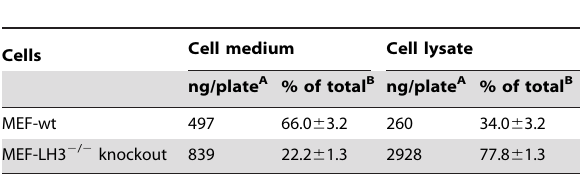
Table 1. Distribution of recombinant adiponectin in MEF cell lysate and cell culture